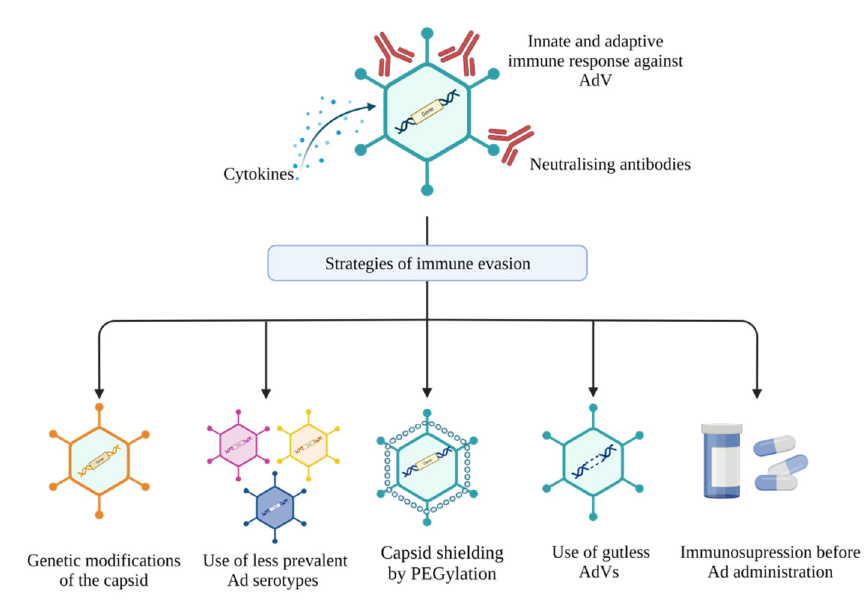
Figure 1. Strategies to avoid immune responses to adenoviral vectors (AdVs). AdVs may elicit both innate and adaptive immune responses to vector proteins. Strategies to evade these immune responses include genetic modification to the viral capsid, use of less prevalent Ad serotypes, shielding the viral capsid by PEGylation, removal of viral sequences to generate gutless AdVs, and administering immunosuppressive drugs before vector injection (created with Biorender.com).